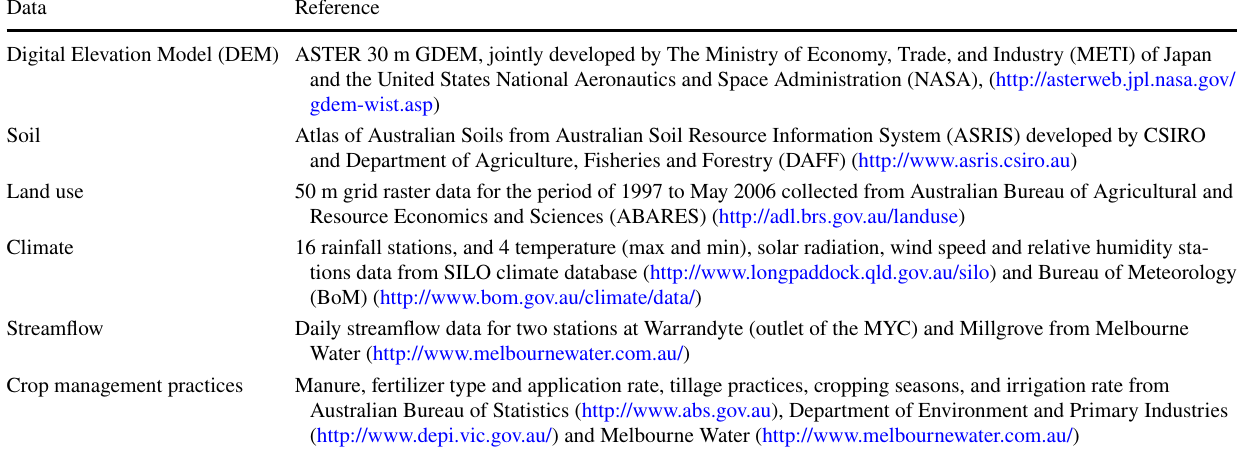
Table 6 SWAT model data reference (Das et al. 2022)